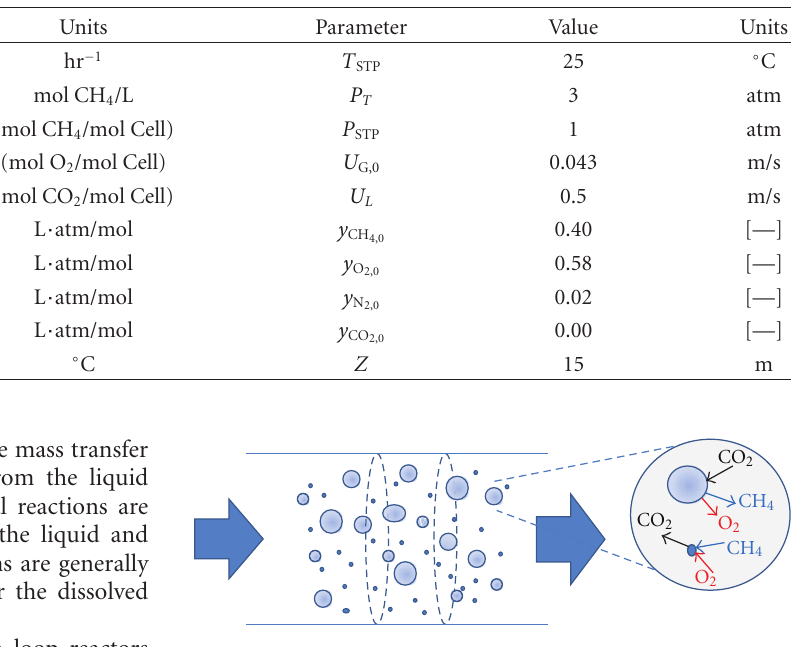
Figure 3: Schematic representation of the bubbly flow and inter- phase mass transfer, taking place in pipe-loop